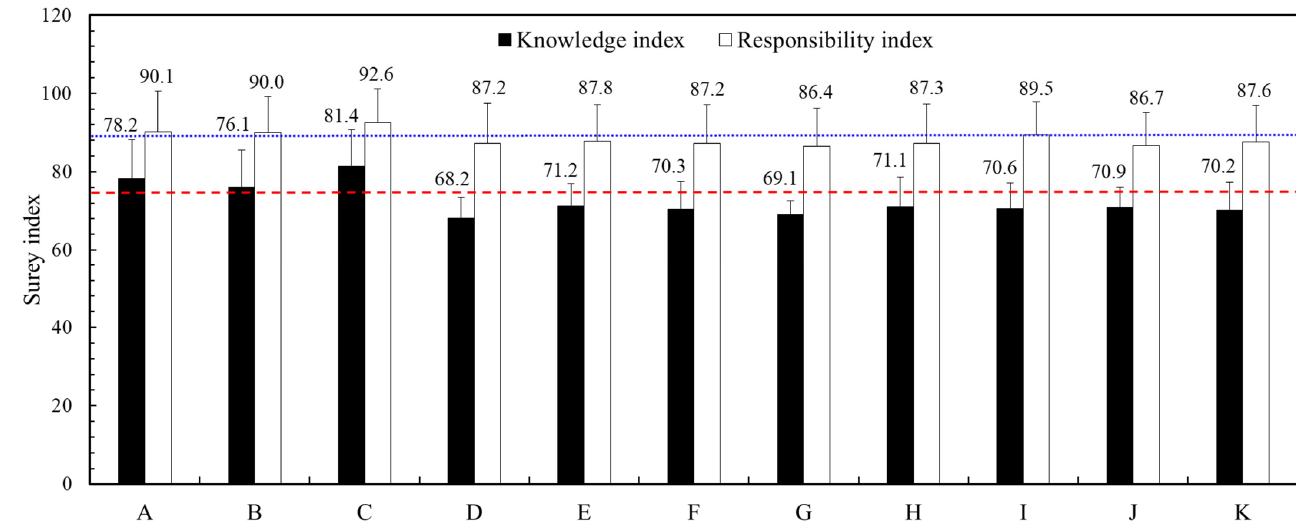
Figure 1. The knowledge and responsibility indexes corresponded to each job category. A: student, B: civil servant, C: board certification, D: financial industry, E: information technology, F: service and sale, G: communication and culture, H: manufacturing, I: construction, J: agriculture, forestry, fisheries and animal husbandry, K: freelance. The dash line portrays overall mean of knowledge and the dot line indicates overall mean of responsibility index.